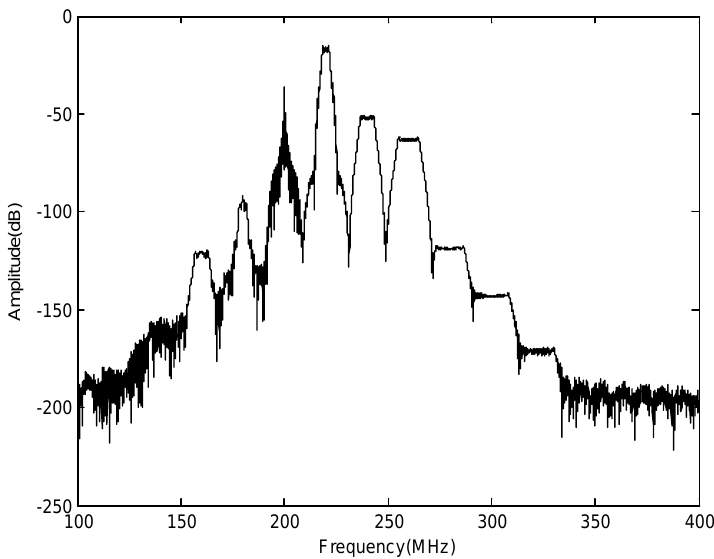
Figure 16. Frequency spectrum of amplifier output signal.